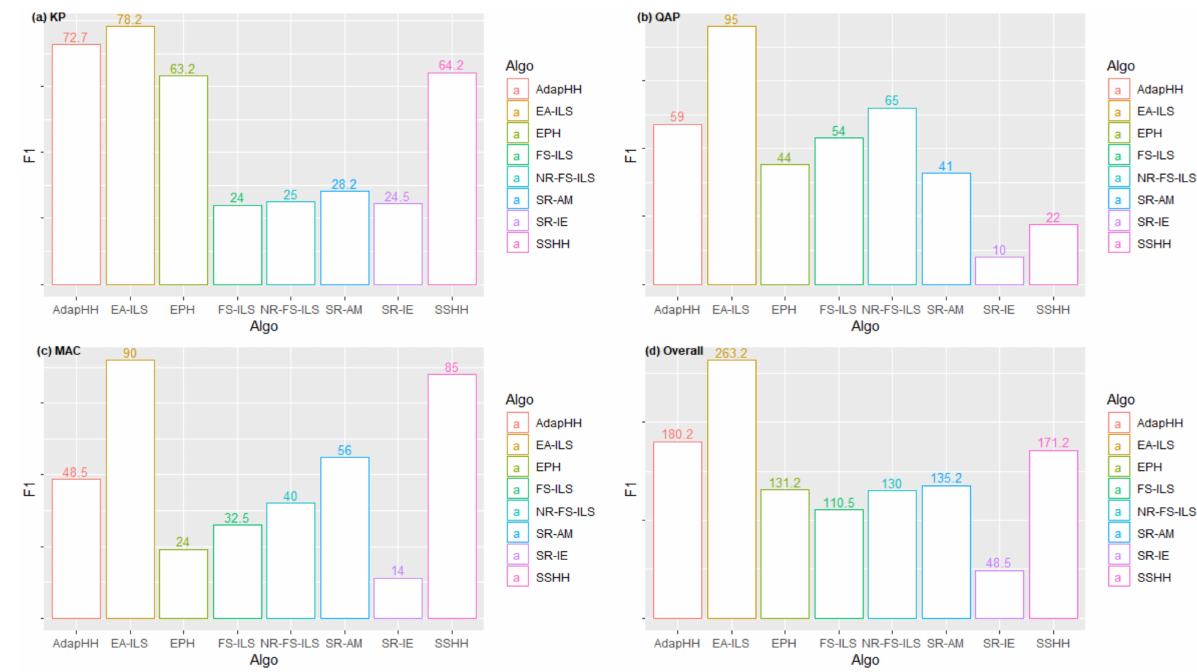
Figure 3. F1 scores of the hyper-heuristics on the three problem domains ( a – c ) and the sum of scores across the three domains ( d ).